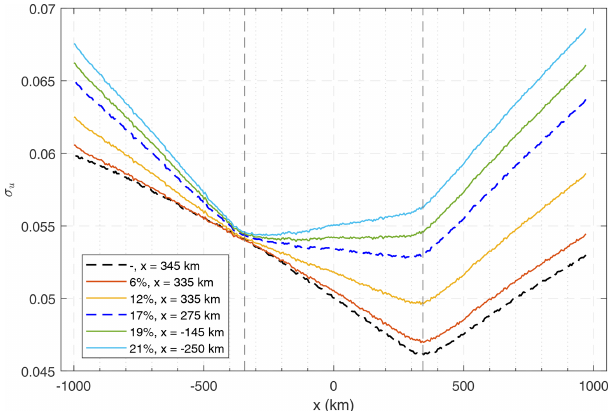
Figure 14. Comparison between simulations assuming different rms fluctuation levels on the inbound bubble and constant fluctu- ation levels on the outbound bubble ( σ (cid:49)ρ/ρ, 2 = 17%). The legend shows the σ (cid:49)ρ/ρ, 1 level and the location estimate along x , given after the σ u global minimum. Vertical dashed lines depict the place- ment of the irregularity regions in the simulations. The dashed black curve corresponds to the case of a single bubble in the outbound sector. The dashed blue curve corresponds to the scenario shown in Fig.